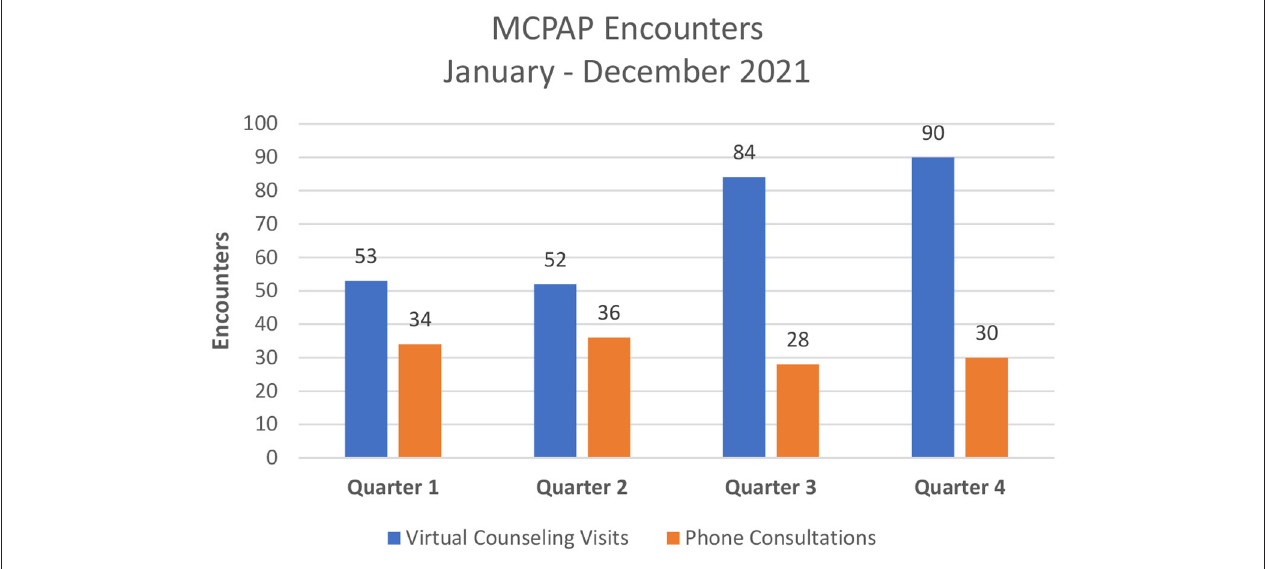
FIGURE 1 | Number of virtual counseling visits and phone consultations per